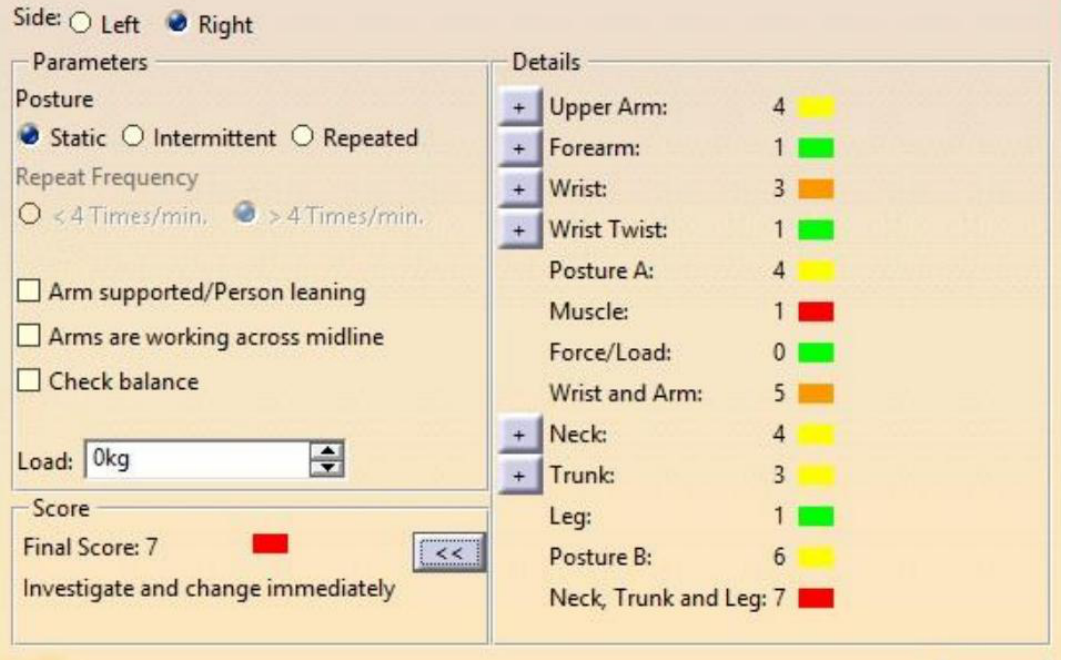
Figure 4. RULA analysis of the typical body